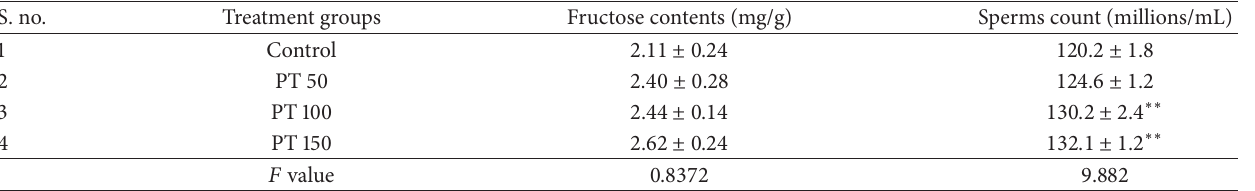
Table 4: Effect of ethanolic extract of plants on the concentration of fructose in seminal vesicle and sperm count. S. no.